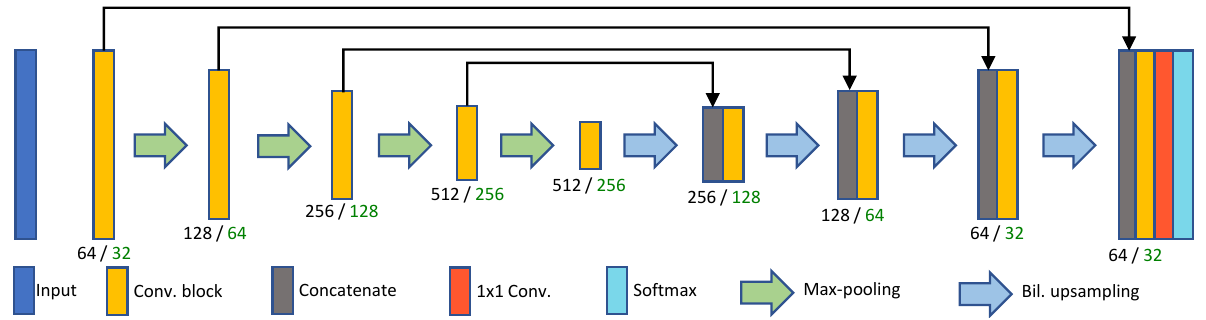
Figure 1. The network architecture. Black numbers at the convolutional blocks indicate the number of feature maps for 2D-U-Net , 3D-2D-Unet or 3D-U-Net . Green numbers indicate the number of feature maps for 3-D-U-Net-light